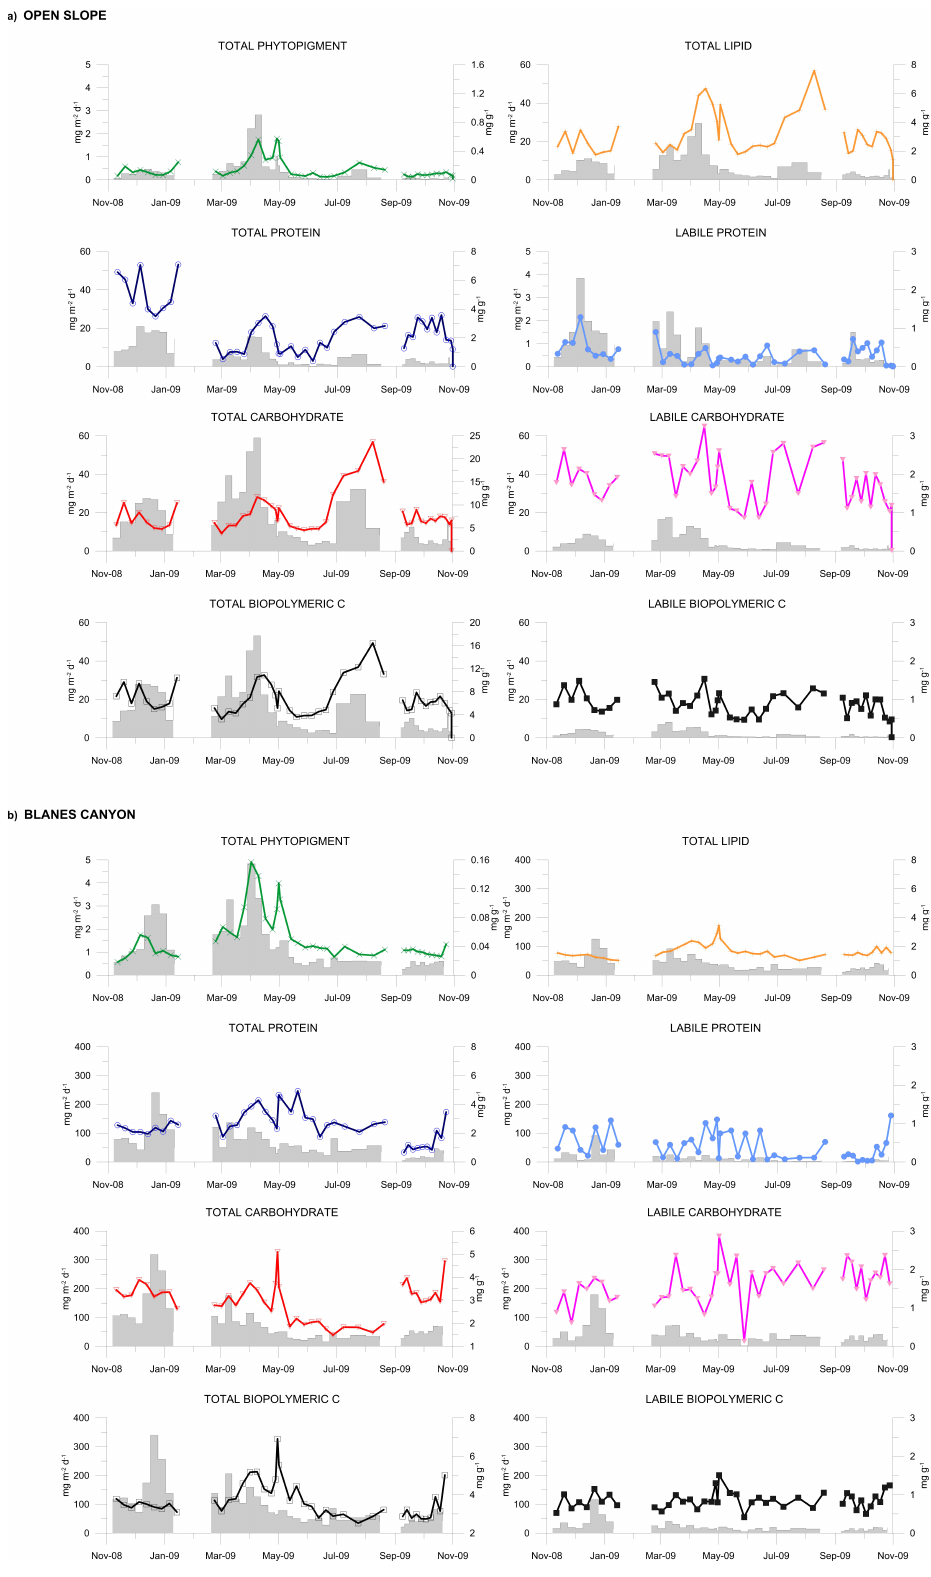
Fig. 4. Time series of organic compounds fluxes (mgm − 2 d − 1 ) and organic compounds contents in the open slope (a) and in the Blanes canyon (b) (line represents the mgg − 1 ) from the sediment traps at 1200m